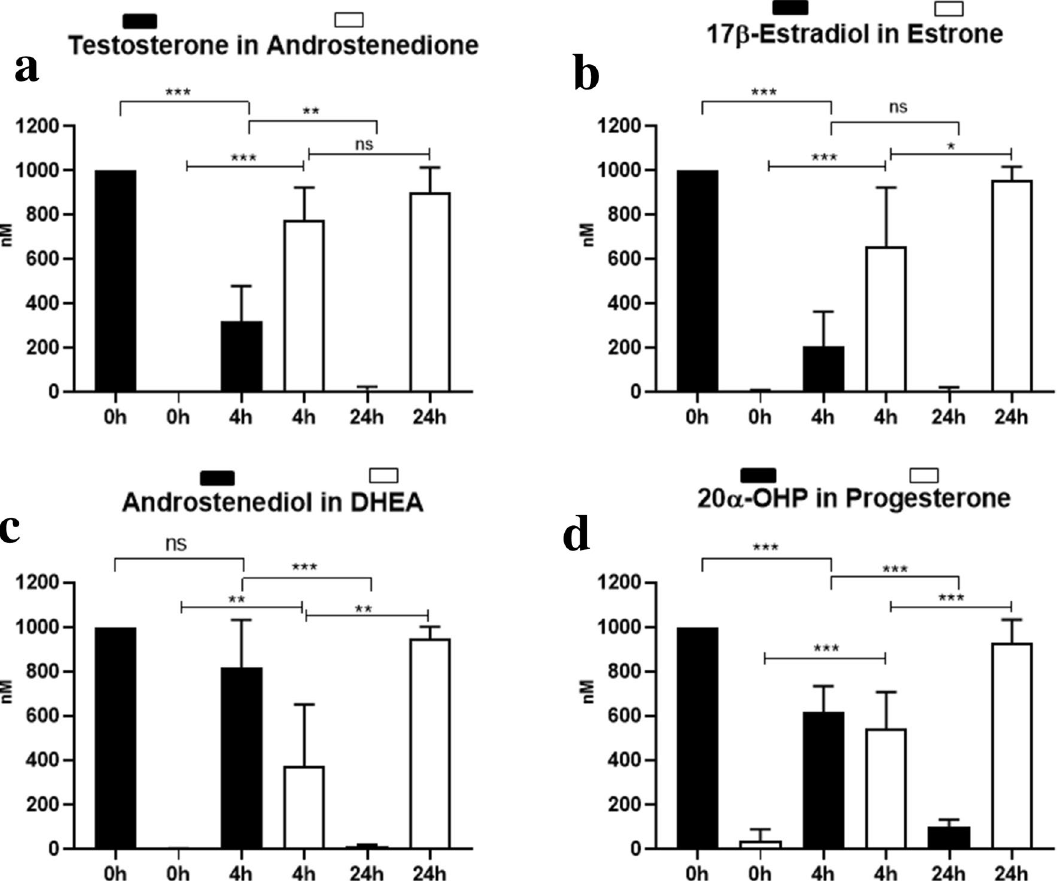
Figure 6. Activity of HSD17B2 in HLECs. Time-dependent conversion of testosterone to androstenedione, 17β-estradiol to estrone, androstenediol to DHEA-S and DHEA as well as 20α-hydroxyprogesterone to progesterone was assessed by LC–MS. Data were normalized to condition at 0 h = 1000 nM = 10−6 M for each compound. Y-axis shows steroid hormone concentrations in nM. Testosterone was significantly converted to androstenedione (testosterone 0 h/4 h/24 h: *** p < 0.0001/** p = 0.0019; androstenedione 0 h/4 h/24 h: *** p < 0.0001/ns). 17β-estradiol was significantly converted to estrone (17β-estradiol 0 h/4 h/24 h: *** p < 0.0001/ ns; estrone 0 h/4 h/24 h: *** p < 0.0001/* p = 0.01). Androstenediol was significantly converted to DHEA (androstenediol 0 h/4 h/24 h: ns/*** p < 0.0001; DHEA 0 h/4 h/24 h: ** p = 0.0087/** p = 0.0002). 20α-OHP was significantly converted to progesterone (20α-OHP 0 h/4 h/24 h: *** p < 0.0001/*** p < 0.0001; progesterone 0 h/4 h/24 h: *** p < 0.0001/*** p < 0.0001). One-way ANOVA, Dunnett’s multiple comparisons test, n = 3. Black rectangle/column: substrate. White rectangle/column: product. * p < 0.05, ** p < 0.01, *** p < 0.0001, ns = not